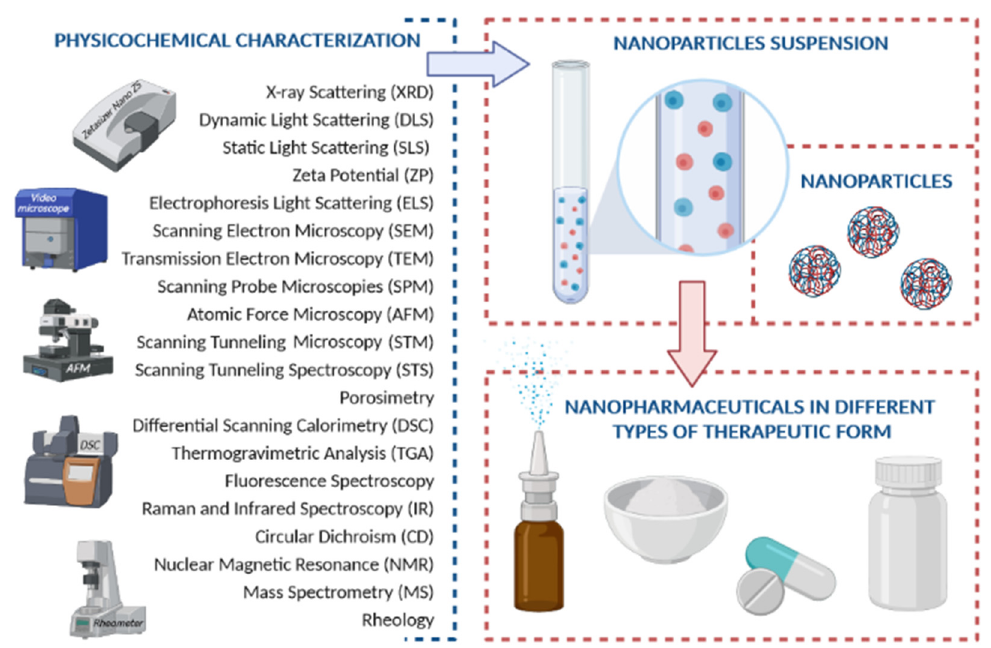
Figure 1. Graphical summary of the physicochemical methods utilized for the characterization of nanopharmaceuticals [own drawing].